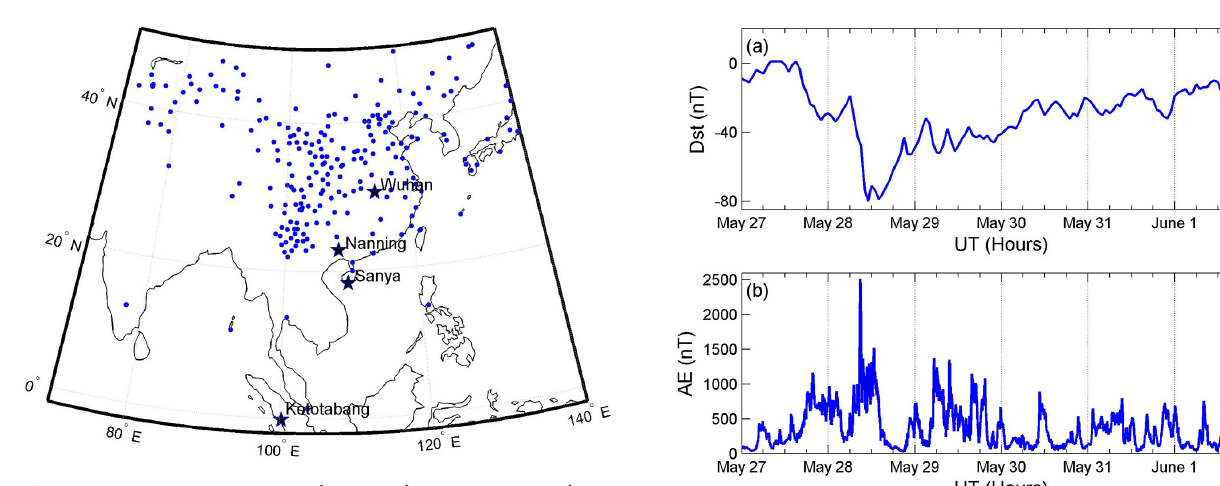
Fig. 1. Location of GPS stations (blue dots) and ionosondes (aster- isks) in East Asia.